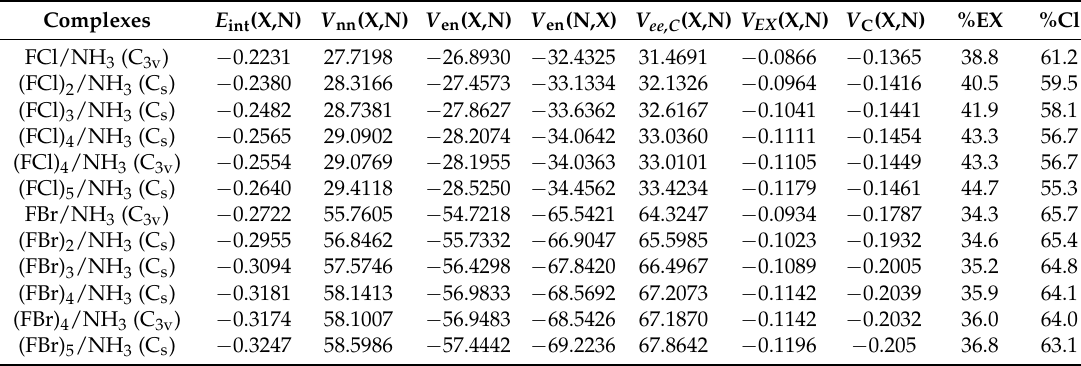
Table 4. IQA interatomic contribution in the X ··· N